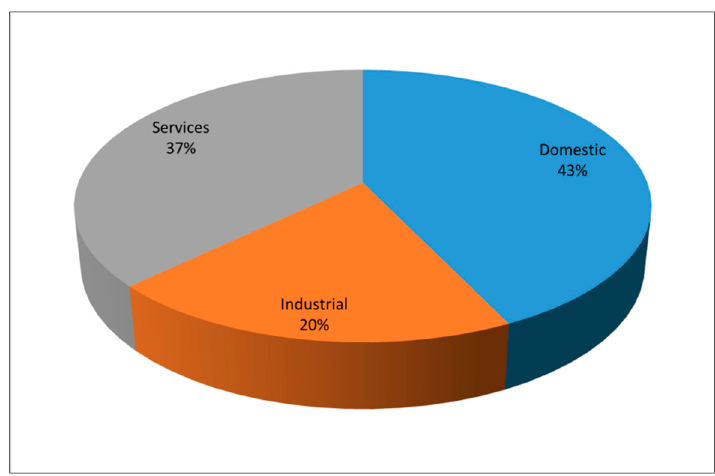
Figure 4. Type of consumer owner of the self-consumption facility.